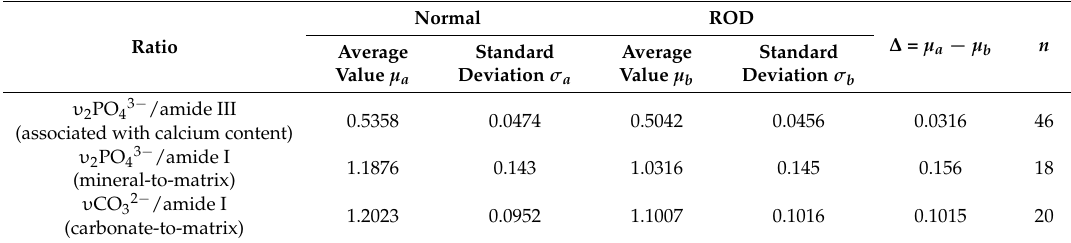
Table 1. Computationally determined values of the ratios of biomarkers of interest and the number of spectra sufficient to distinguish between samples for typical statistics power of β = 90% and α = 0.05. Normal Ratio